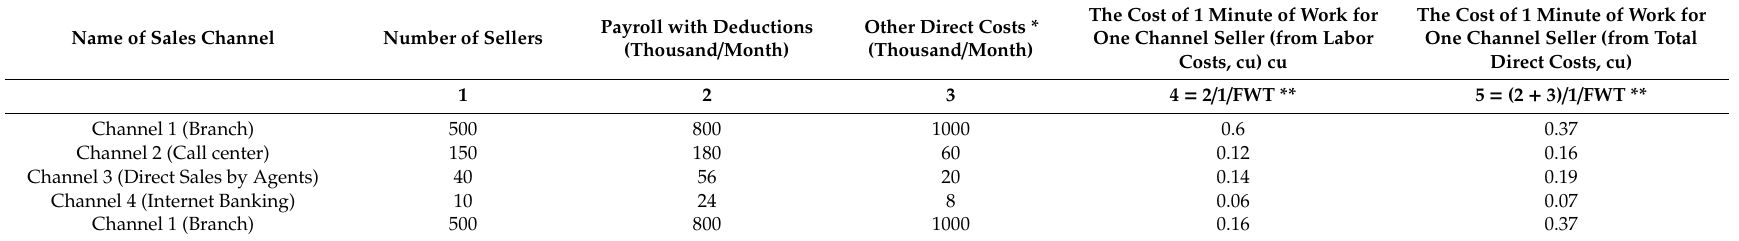
Table 1. Calculation of the cost of 1 min of work channel employee.